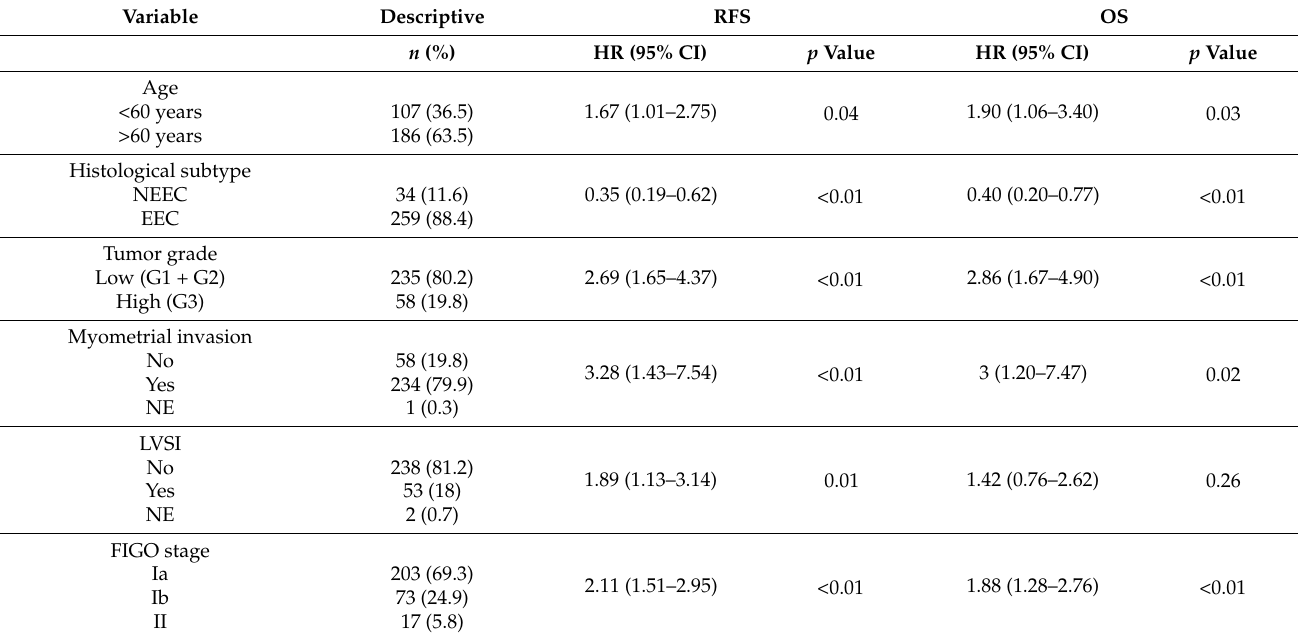
Table 1. Clinicopathological characteristics univariate analysis.